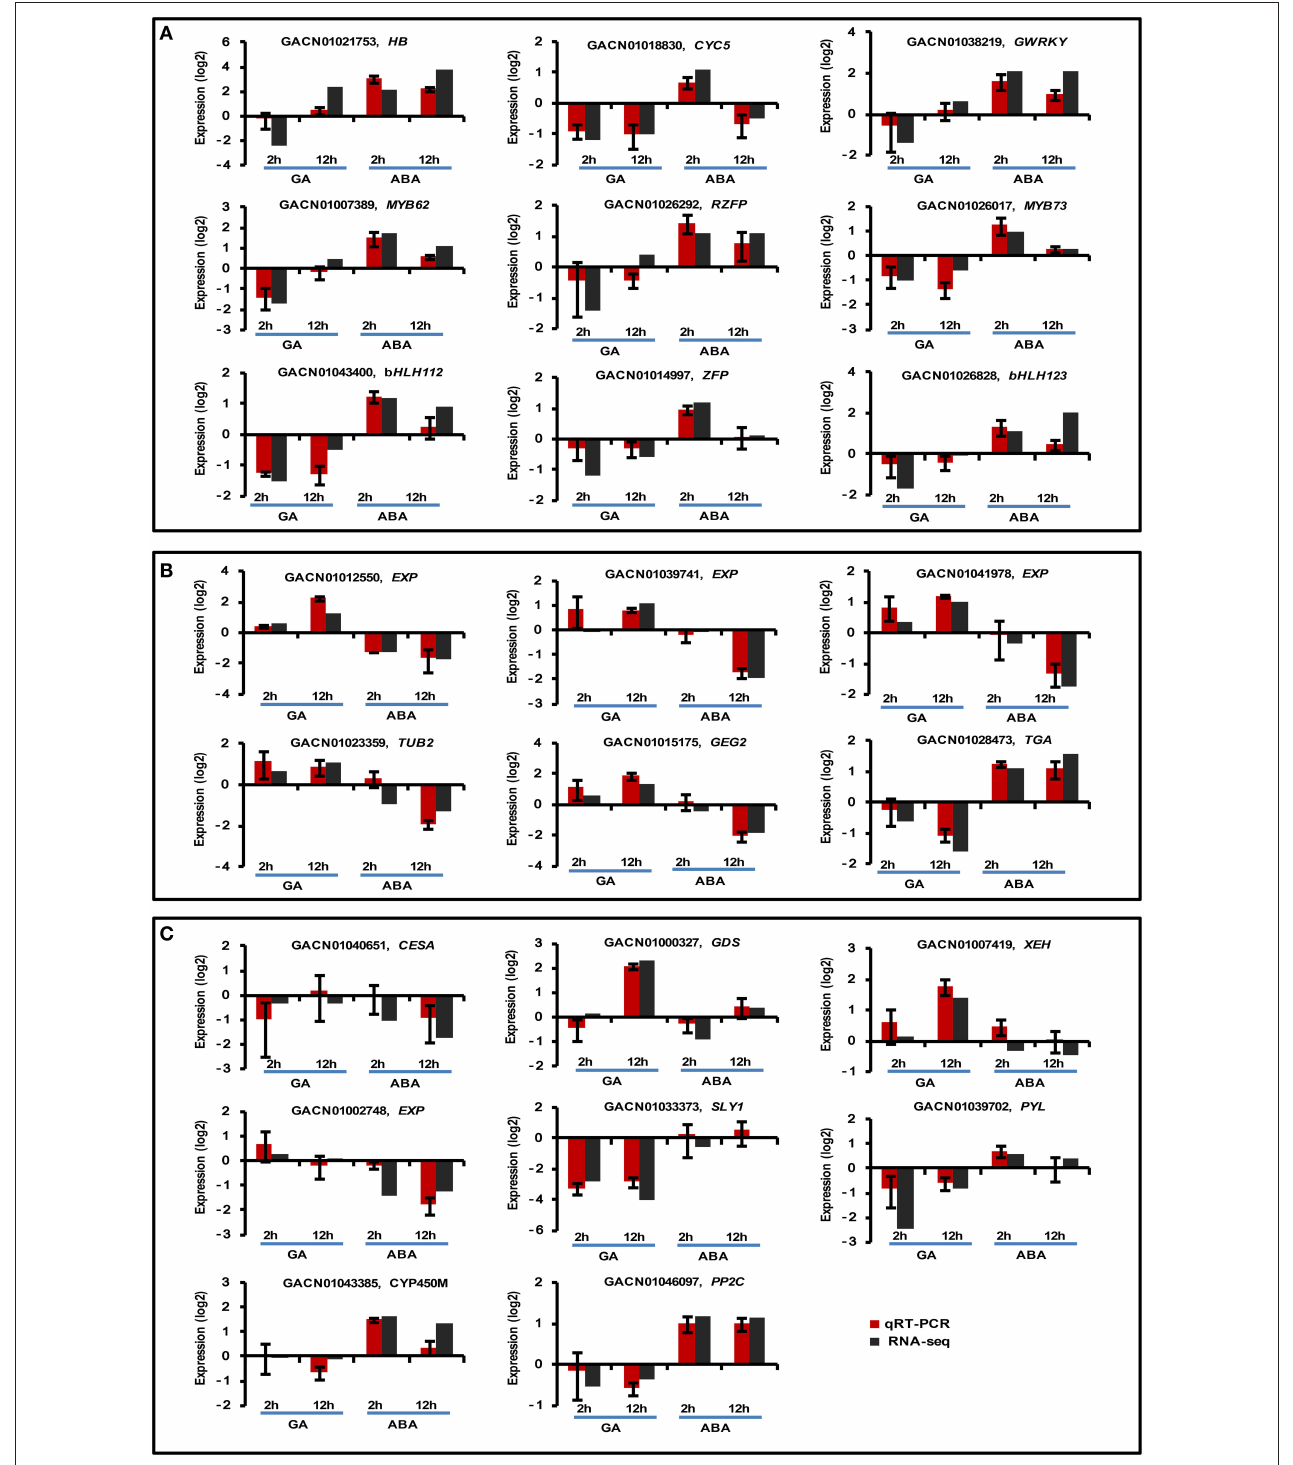
as described in the text. Three biological repeats were included for each condition. The y-axis indicates the expression of each DEG under the denoted conditions relative to control by log2-transformed RQ value for qPCR or fold-change value for RNA-seq. Error bars indicate the interval between the log2-transformed values of maximum or minimum